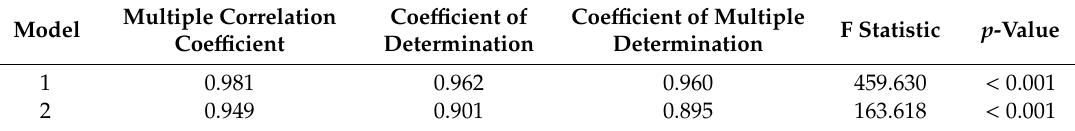
Table 1. Statistics of the regression models and the variance analysis.